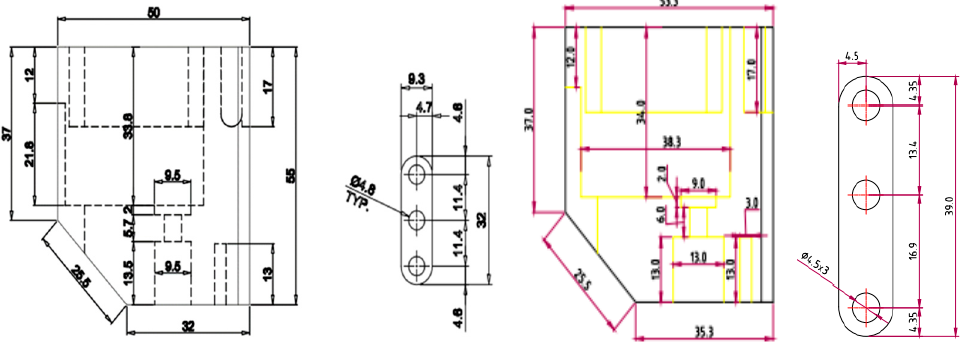
Figure 11. Before and after drawing of power cord.